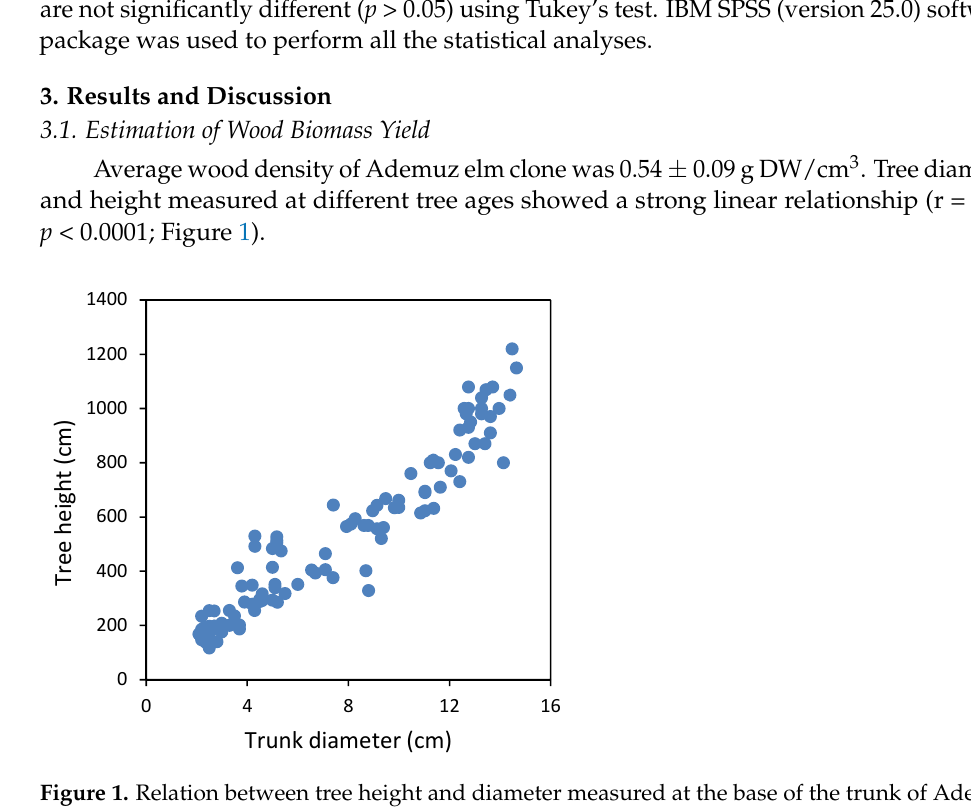
Figure 1. Relation between tree height and diameter measured at the base of the trunk of Ademuz elm clone.